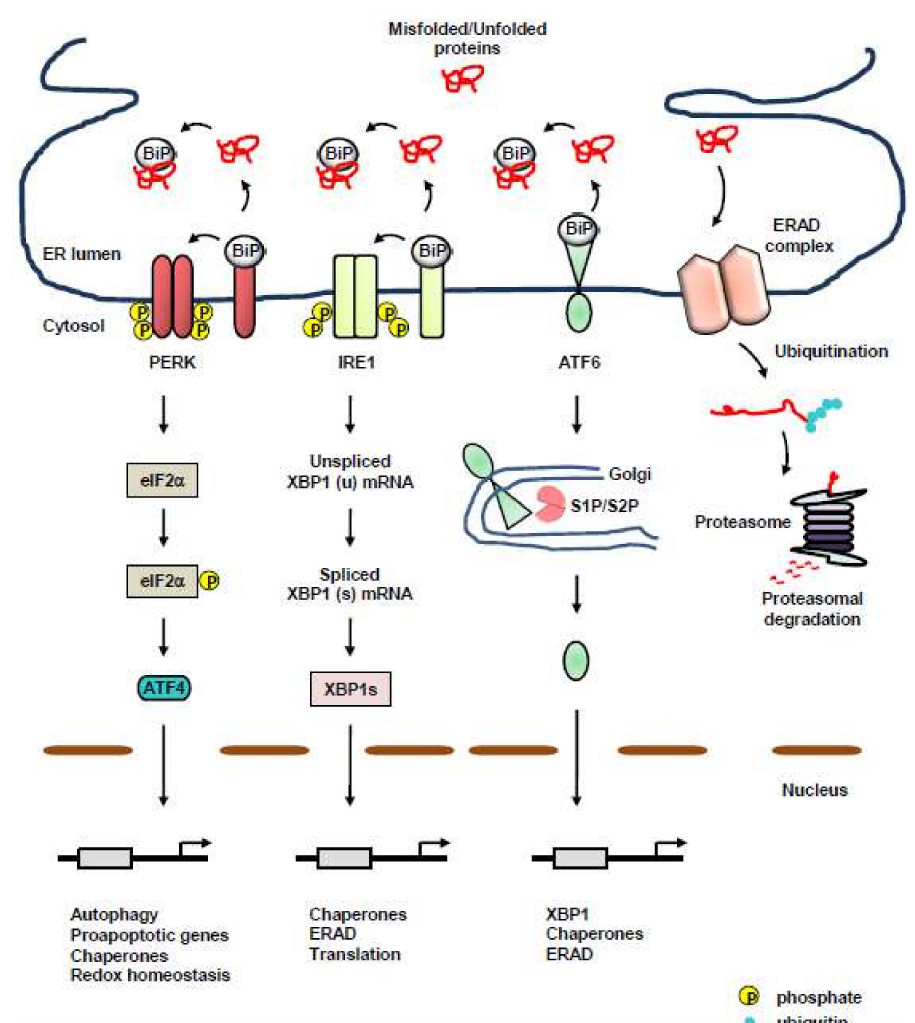
Figure 1. Protein quality-control machineries of the endoplasmic reticulum (ER). Protein quality-control machineries of the ER consist of three axes: acceleration of adequate protein folding, activation of the unfolded protein response (UPR), and protein clearance via ER-associated degradation (ERAD), or autophagy. UPR is composed of three transmembrane ER-resident stress sensors, inositol-requiring protein 1 (IRE1), activating transcription factor 6 (ATF6), and protein kinase RNA (PKR)-like ER kinase (PERK). Under unstressed conditions, the luminal domains of these UPR sensors are kept inactive via binding to a chaperone, binding immunoglobulin protein (BiP). Upon ER stress, BiP dissociates from the ER sensors, leading to the activation of UPR. The PERK/ATF4 axis induces the expression of chaperones and genes involved in autophagy, apoptosis, and redox homeostasis. The IRE1/X-box binding protein 1 (XBP1) axis facilitates the transcription of a subset of UPR genes linked to adequate folding and secretion of proteins, as well as ERAD [23–26]. Activated ATF6 induces the expression of chaperones, XBP1, and genes involved in ERAD. ERAD is also the protein quality-control machinery of the ER for removing terminally misfolded, unassembled, or tightly regulated proteins via the cytosolic ubiquitin–proteasome system (UPS). Following retrotranslocation across the ER membrane, ERAD substrates are ubiquitinated and degraded by the proteasome in the cytoplasm. Black arrow, facilitation; red line, misfolded/unfolded